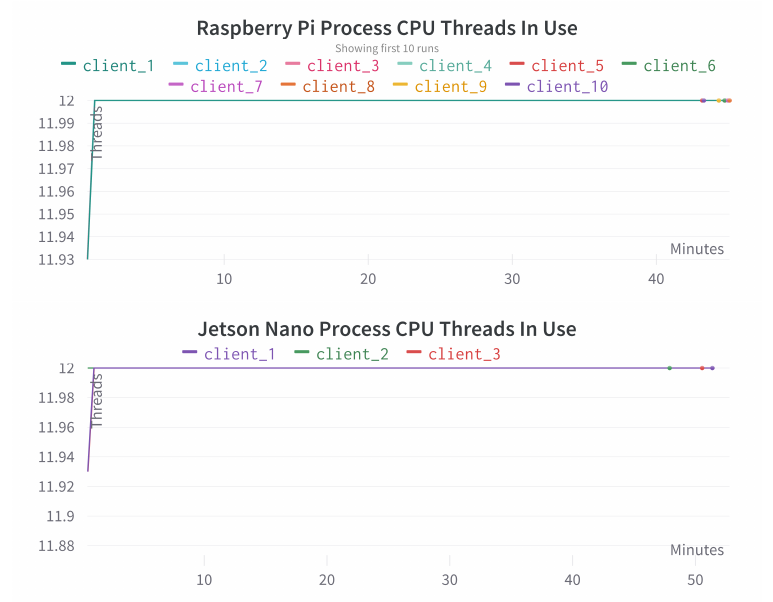
Figure 10. Process CPU threads in use comparison for different Raspberry Pi and Jetson Nano devices. The x-axis represents the time in minutes, the y-axis represents the number of CPU threads in